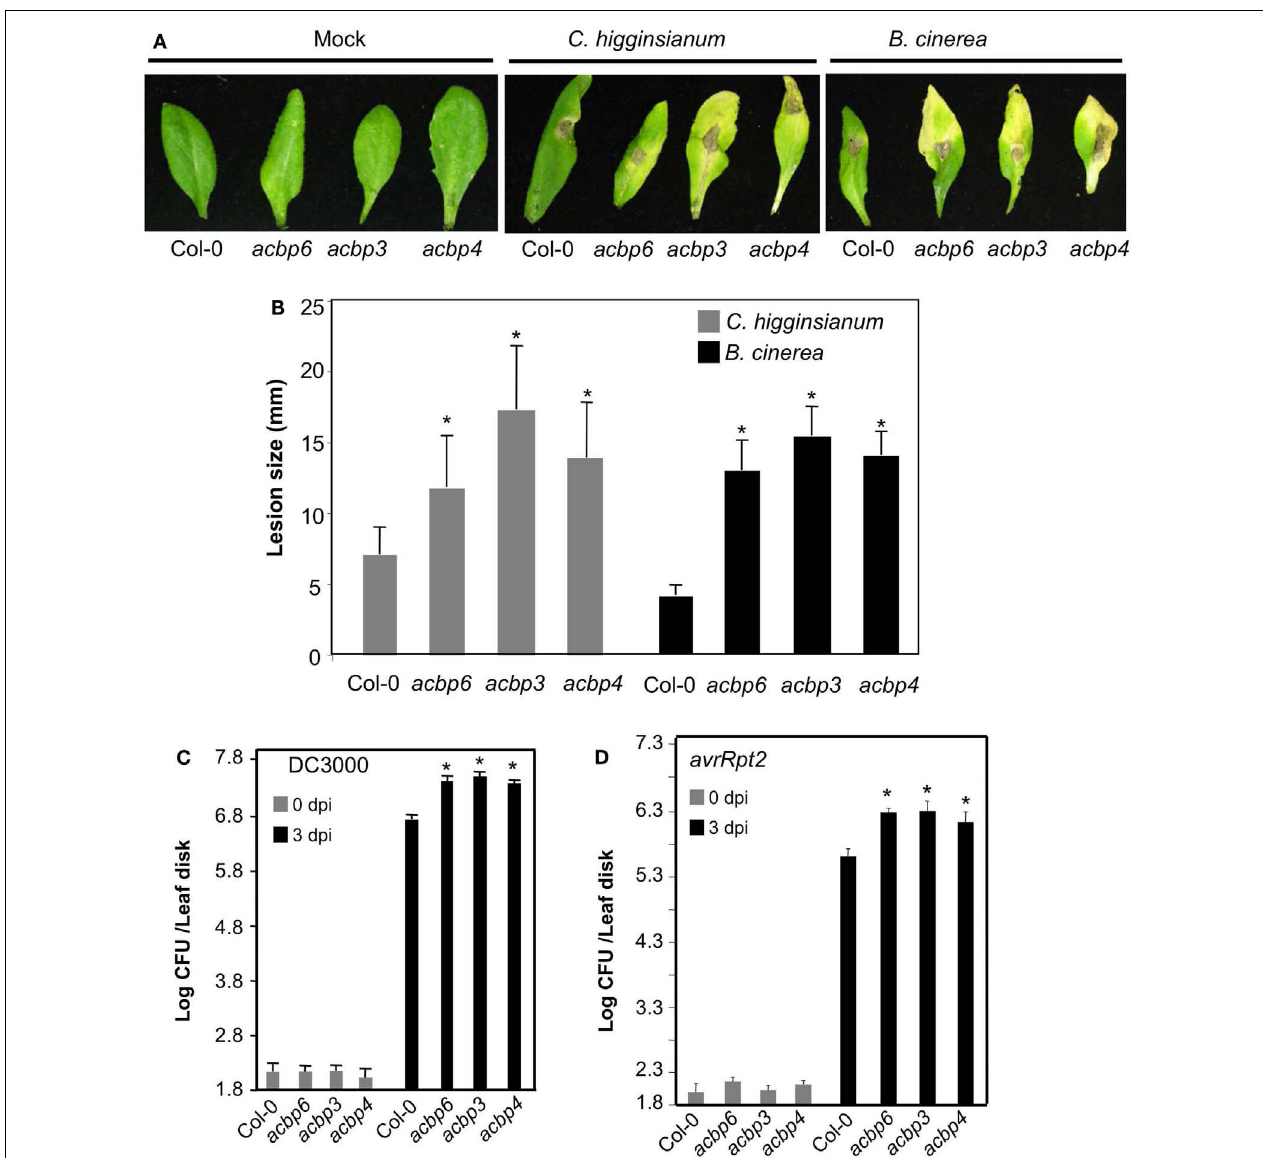
of control (Col-0; P < 0.05). Error bars indicate SD. (C) Growth of virulent P. syringae on leaves from Col-0 or acbp mutant plants. Error bars indicate SD. Asterisks indicate data statistically significant from that of control (Col-0; P < 0.05, n = 4). (D) Growth of avirulent ( avrRpt2 ) P. syringae strains on Col-0 or acbp mutant plants. Error bars indicate SD. Asterisks indicate data statistically significant from that of control (Col-0; P < 0.05, n = 4). Bacterial growth presented as the LOG of colony forming units (CFU) per leaf disk, was monitored at 0 and 3dpi. Experiments in (C,D) were repeated six times each with similar